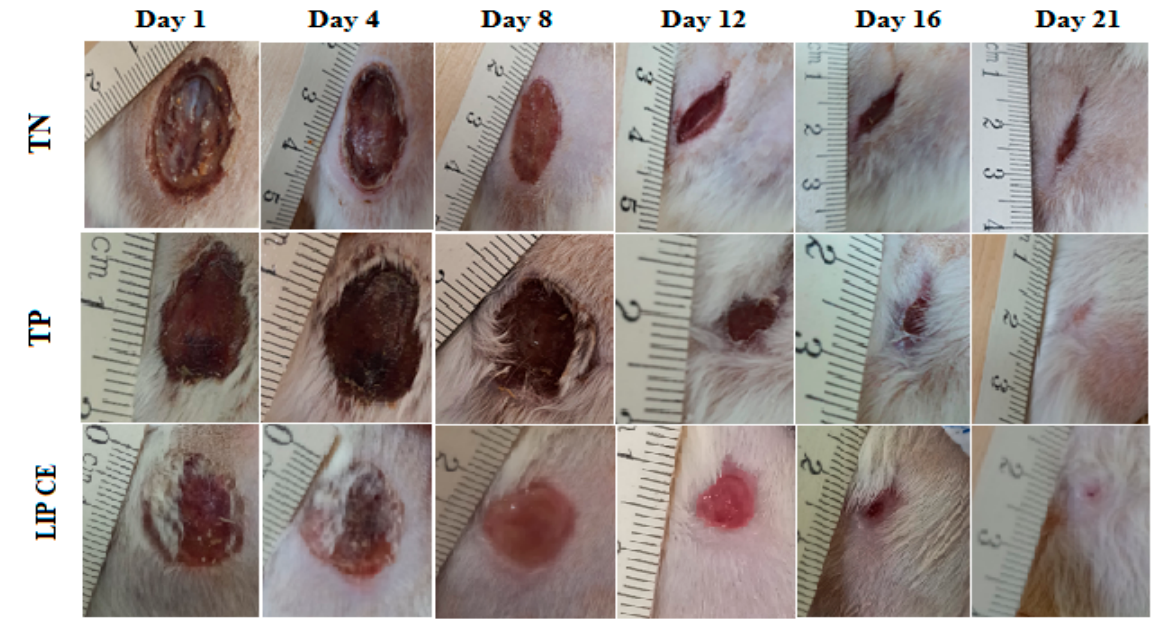
Figure 7. Images of animal wound areas on 1st, 4th, 8th, 12th, 16th, and 21st day of the experiment. CE, Caralluma europaea ; TN, Negative control; TP, Positive control; Lip, Lipids.